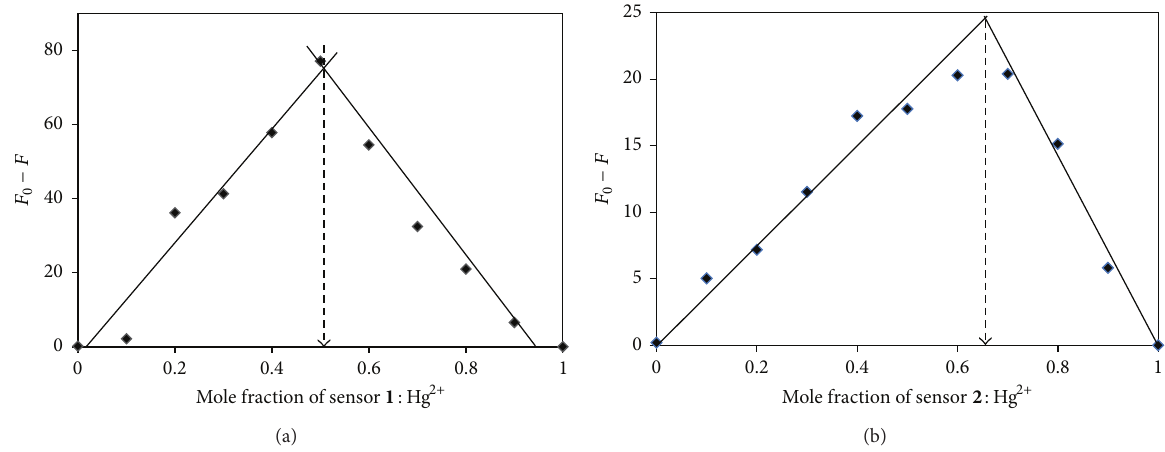
Figure 5: Job’s plots for (a) 1 with Hg 2+ in CH 3 CN and (b) 2 with Hg 2+ in CH 2 Cl 2 . The total concentrations of [Sensors] + [Hg 2+ ] are 1 𝜇 M.